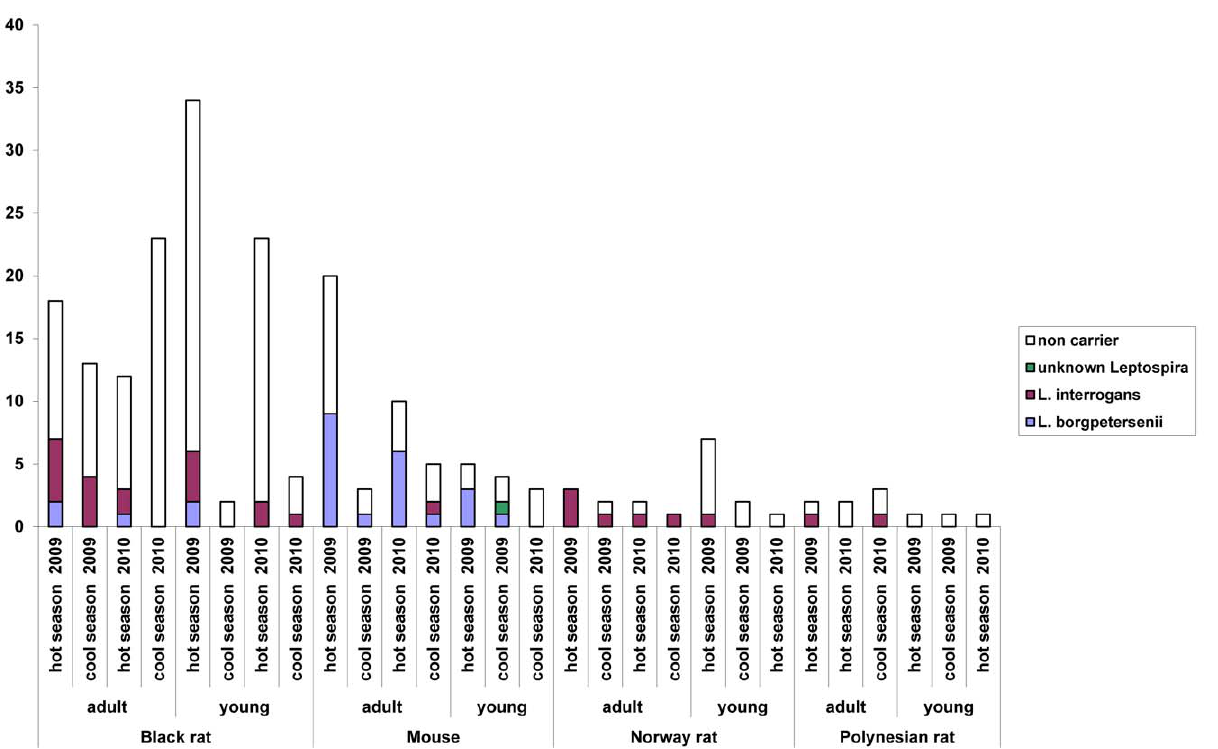
Figure 5. Rodents captured during our study and their Leptospira carriage. (The animals for which the stage (adult/juvenile) could not be determined are not represented.).